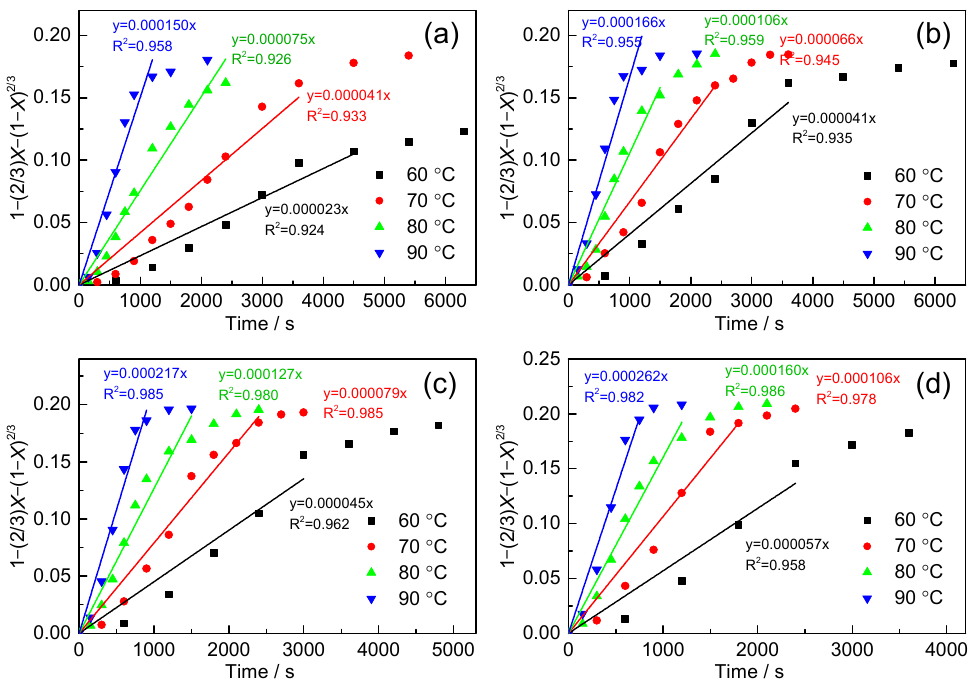
Figure 8. Plots of 1 − (2/3) X − (1 − X ) 1/3 versus time for different leaching temperature with L / S ratio of 20:1 and rotating speed of 200 r/min. ( a ) C F - = 8 mol/L; ( b ) C F - = 10 mol/L; ( c ) C F - = 12 mol/L; ( d ) C F - = 14 mol/L.